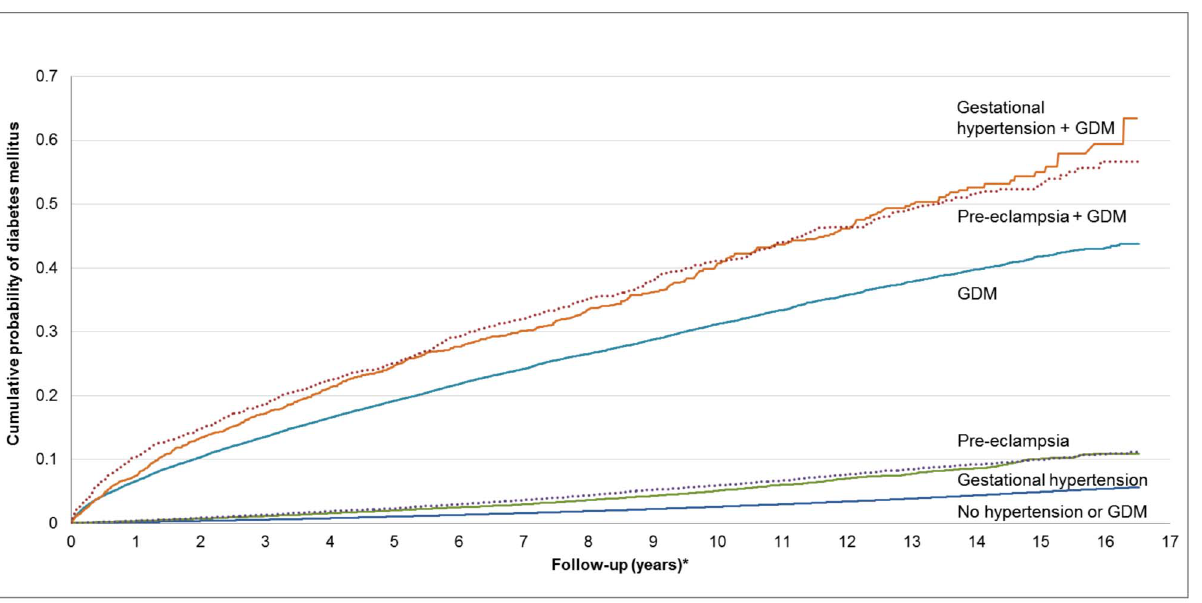
Figure 2. Cumulative future risk of diabetes mellitus in association with a pregnancy affected by preeclampsia, gestational hypertension, and gestational diabetes. *Follow-up period begins 180 d postpartum. This figure was produced using a competing risk method.